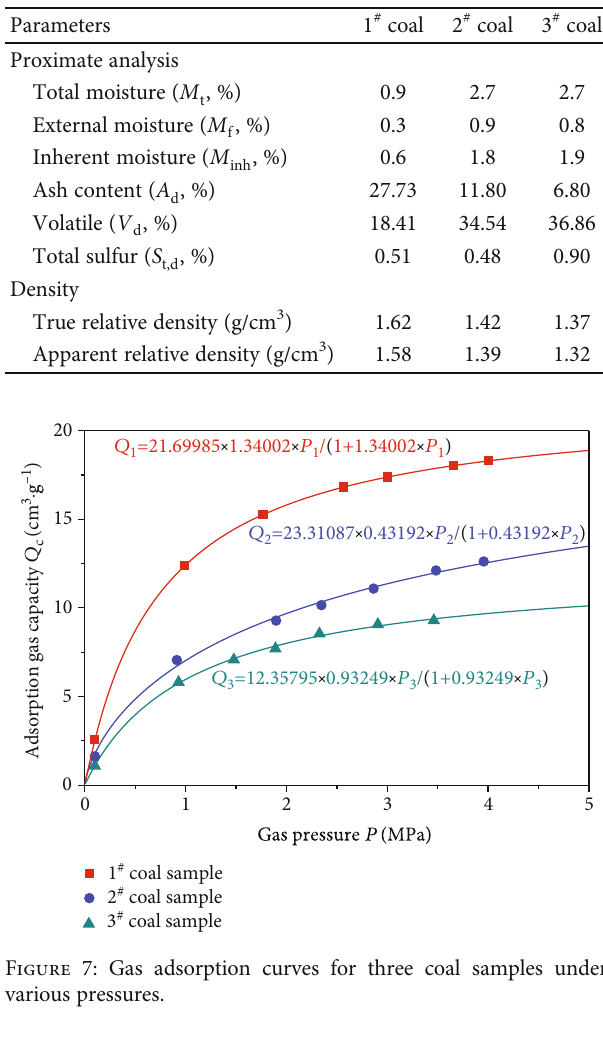
Figure 6: Relationship between simulated gas pressure P and measured gas pressure P ∗ . Table 1: Density and proximate analysis results for coal samples.